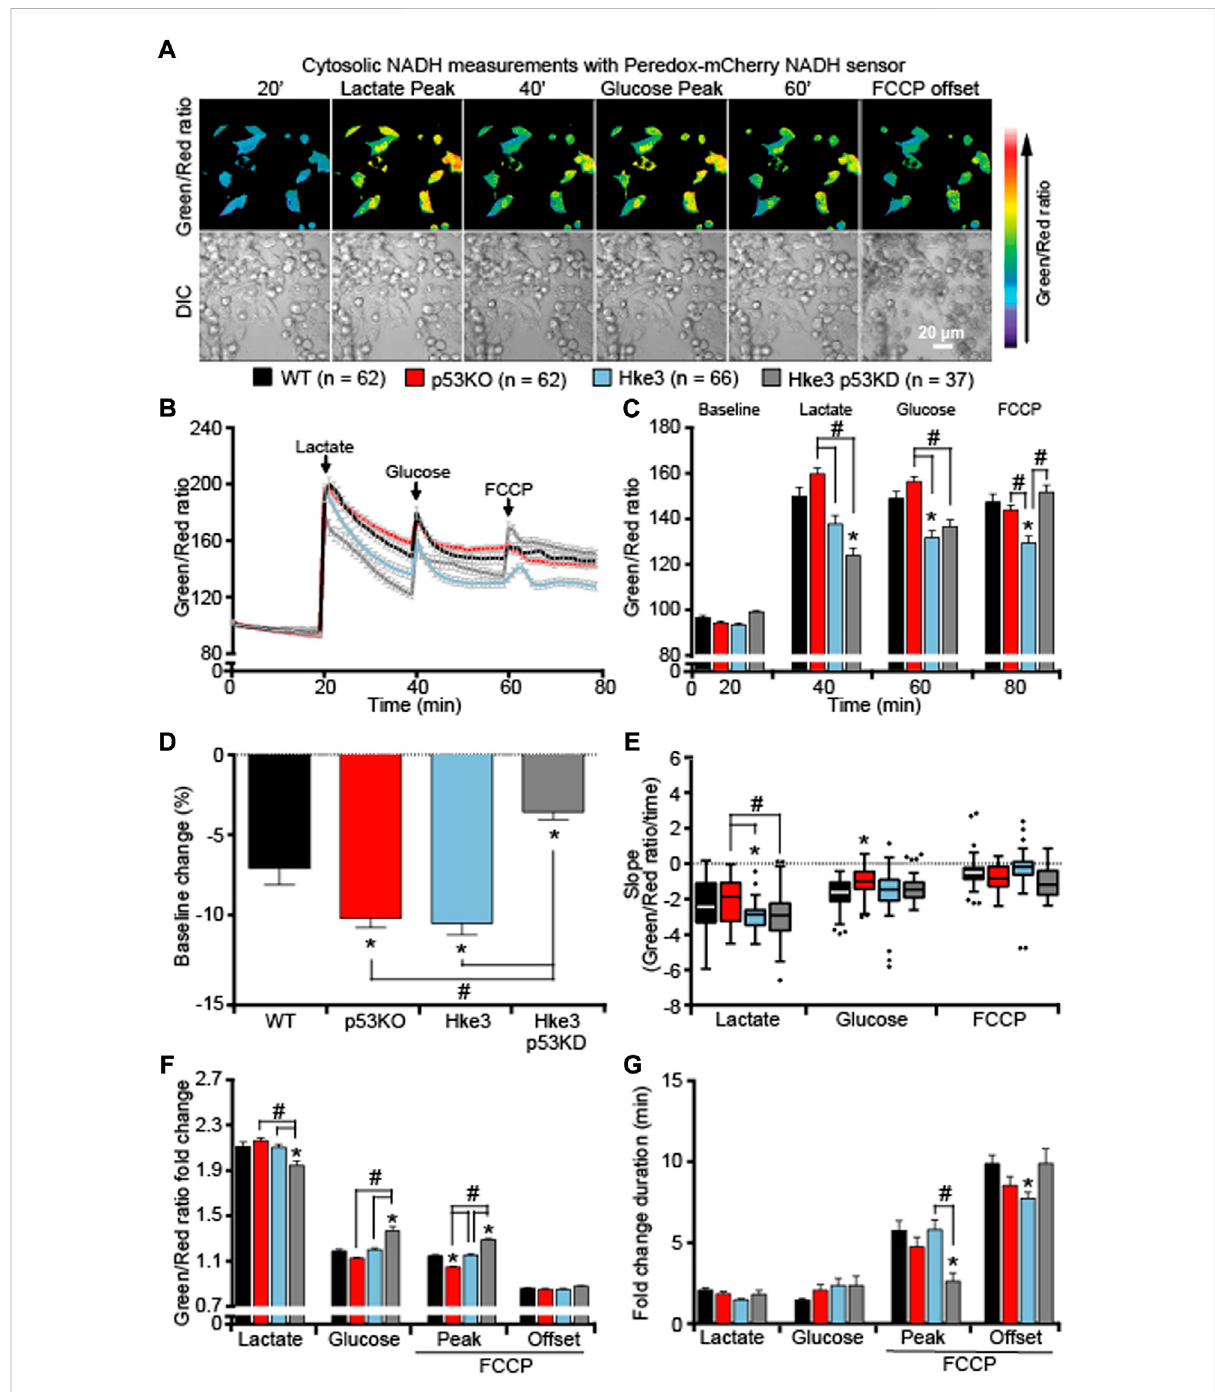
FIGURE 5 Cytosolic NADH oxidation following substrates addition depends on a correct expression of both TP53 and KRAS. WT, p53 KO, Hke3 and Hke3p53KDHCT-116cellswereseparatelytransfectedwiththecytosolic-targetedNADH-sensitivePeredox-mCherry fl uorescentprobe,mounted on the heated stage of an LSM 710 confocal microscope and assayed over 80 min at 37 ° C. Cells were exposed as mentioned and illustrated in Figure 1A. DIC and fl uorescent measurements were recorded for GFP and mCherry by time-lapse confocal microscopy. (A) Peredox imaging data are shown as a ratio images of Green (excitation with 405 nm)/Red (excitation with 561 nm). Representative DIC and Peredox ratio images of Hke3cellswhichreportcytosolicNADHareshownbeforeandafterdrugsaddition.Scalebar=20 µm. (B) Kineticsofallcellsmonitoredareshownas means normalized to baseline ±SEM. (C) Analysis of the cytosolic NADH levels before each drug treatment(20, 40 and 60 min) and at the end of the experiment (80 min), additions are labelled with black arrows on top of the graph. (D) Cytosolic NADH baseline levels over the fi rst 20 min, (E) quanti fi cation of the slope of cytosolic NADH (the change inGreen/Red ratio over time inminutes), (F) themean fold change in Green/Red ratio and (G) the mean duration for change in Green/Red ratio after each treatment are illustrated. Means ± SEM are shown from at least three independent experiments for each cell line (WT, n = 62; p53 KO, n = 62; Hke3 n = 66; Hke3 p53 KD, n = 37). * p ≤ 0.05 compared to WT control cells; # p ≤ 0.05 between cell lines (ANOVA, post-hoc